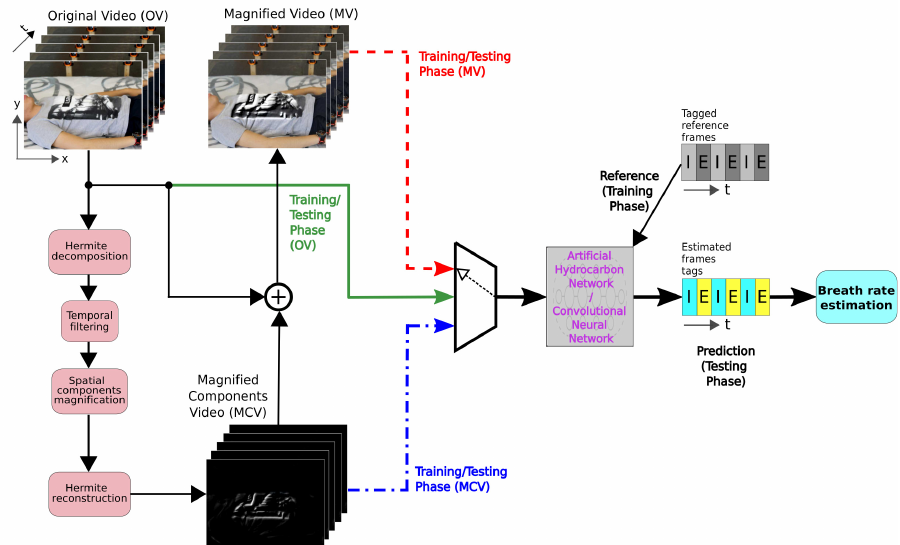
Figure 1. Block diagram of the breath rate estimation system using the AHN or CNN model. The green solid line represents the model training using the original video (OV). The blue point-dash line uses the magnified component video (MCV). The red dashed line represents the approach using the magnified video